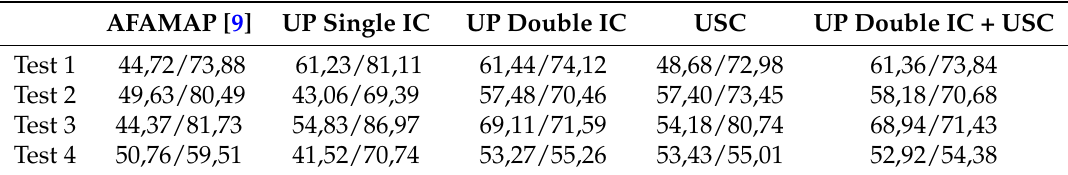
Table 8. Average precision / recall percentage results comparison among each tested algorithm for 4 test